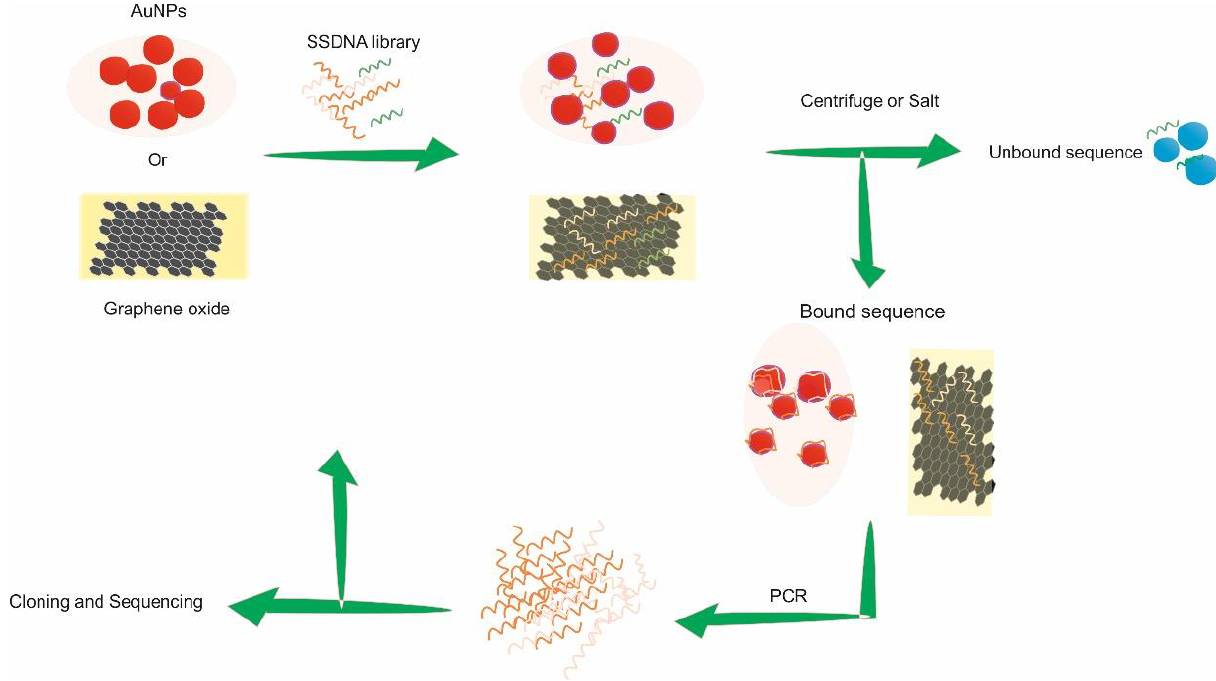
Figure 2. Schematic representation of ‘GO’ and AuNP SELEX.